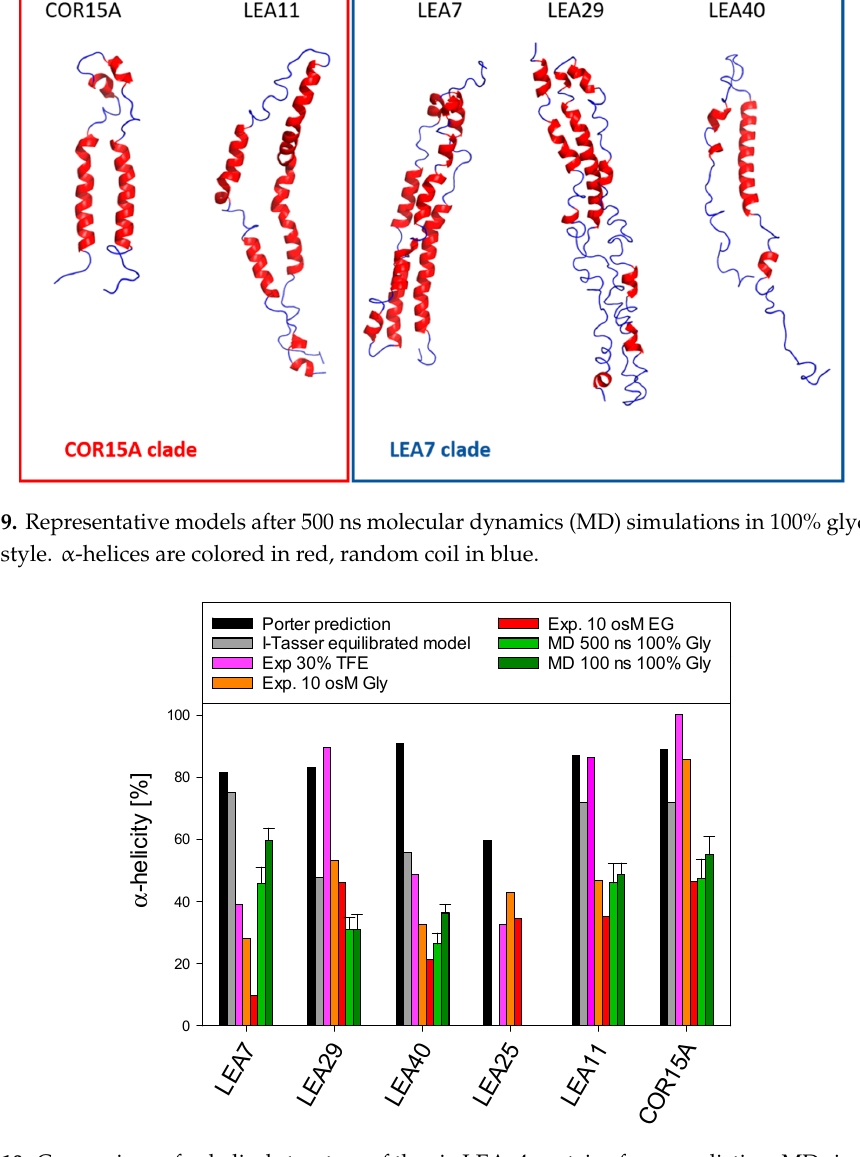
Figure 10. Comparison of α -helical structure of the six LEA_4 proteins from prediction, MD simulation and experiment. Error bars depict SD of five simulation replicate trajectories. Gly— glycerol.